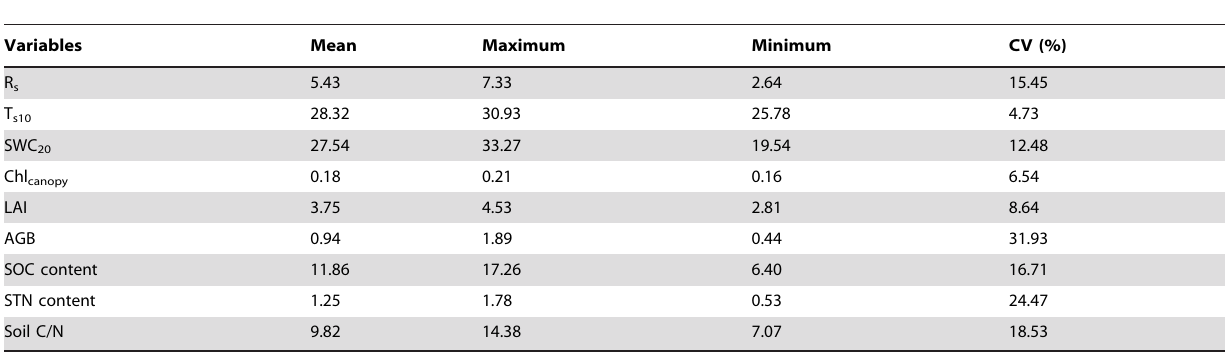
(soil C/N) in maize fields during the peak growing season in three counties in North China.